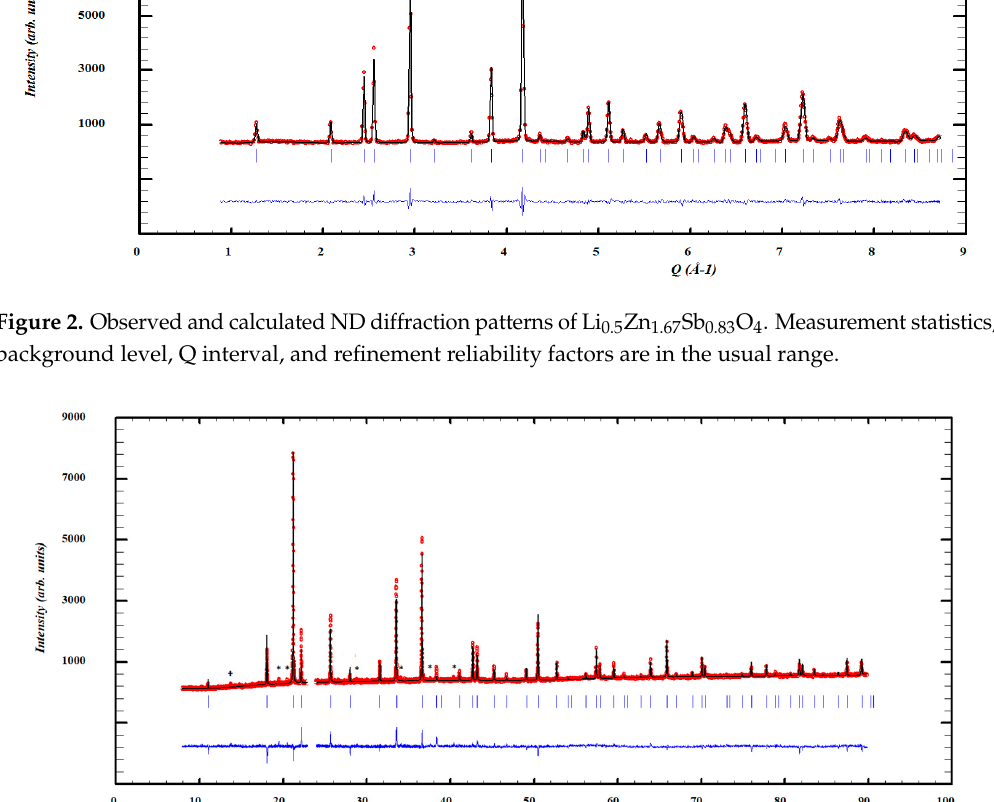
Figure 3. Observed and calculated SyXRD diffraction patterns of Li 0.5 Zn 1.67 Sb 0.83 O 4 . The diagram shows traces (~1%) of Li 8 PtO 6 (+) and ZnO (*). The small interval around 2 θ ≈ 24° was not taken into